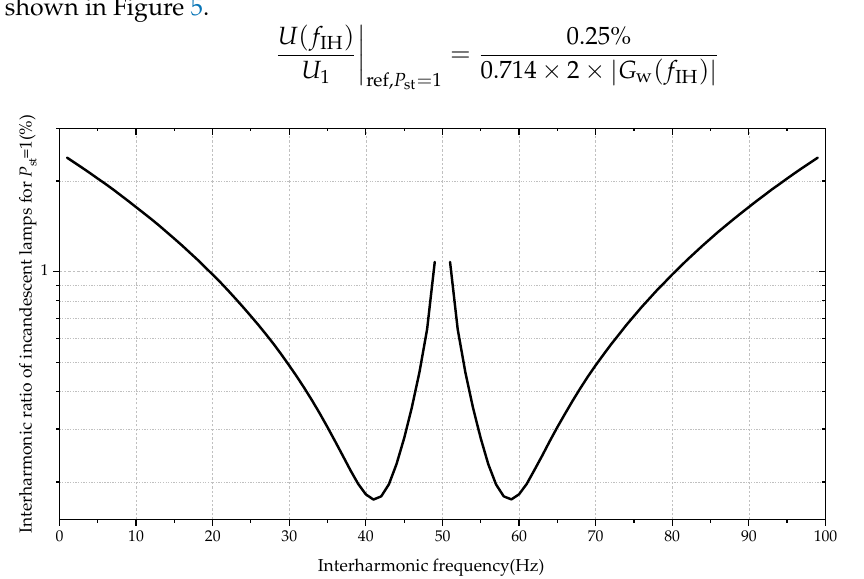
Figure 5. Interharmonic-flicker limit curve of the incandescent lamp.